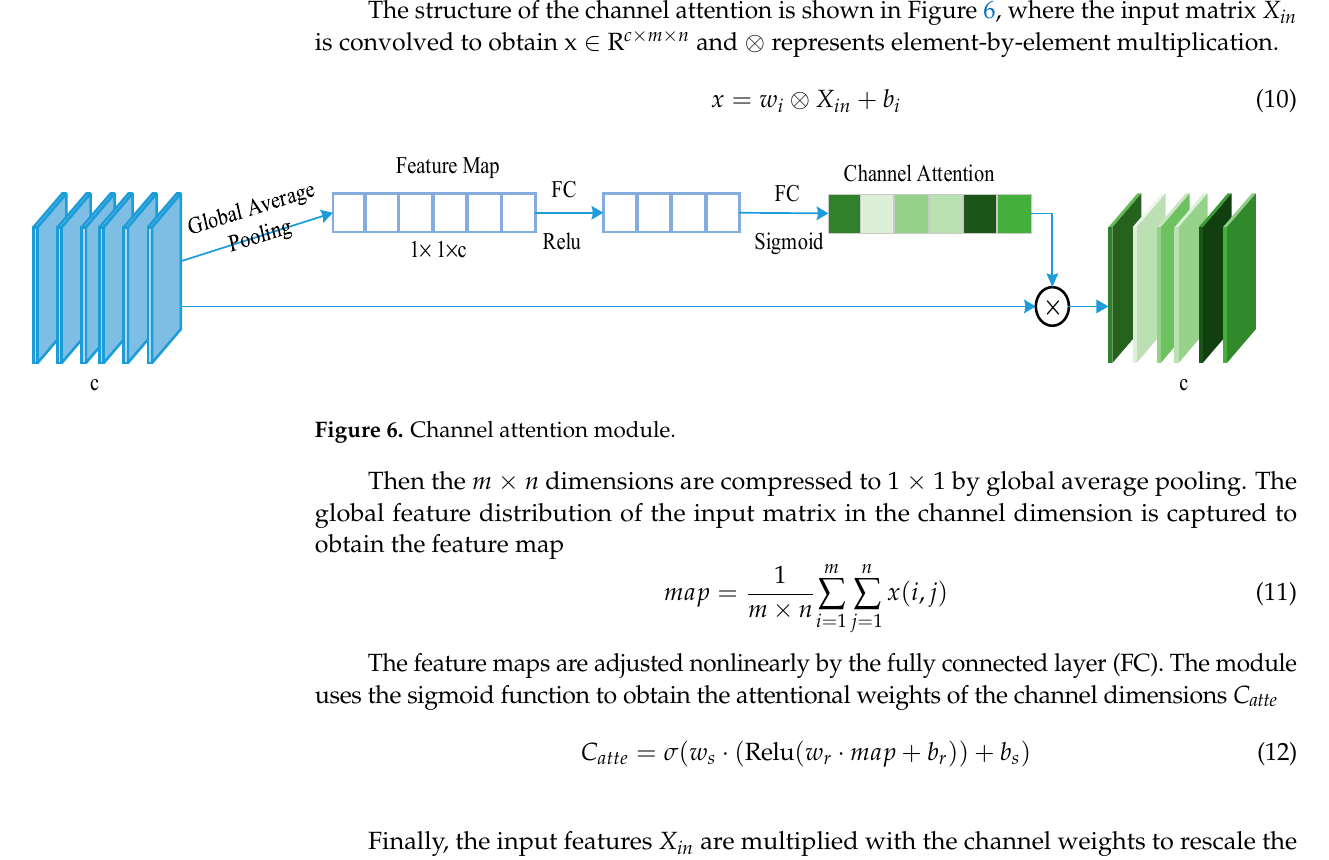
Figure 5. Two-dimensional vibration matrix visualization. ( a ) is the original vibration signal. ( b – f ) are the PF components.